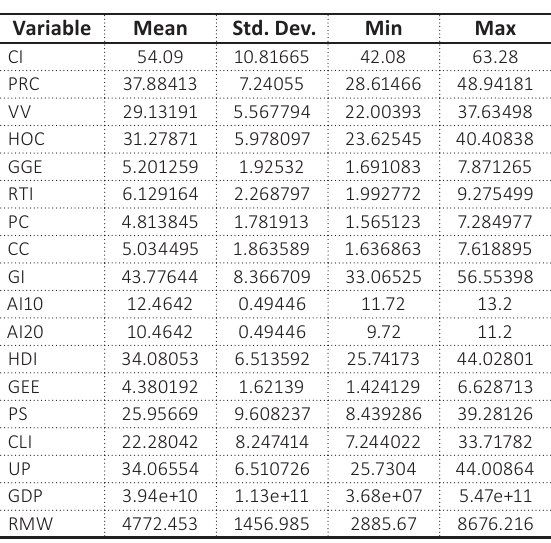
Table 5. Descriptive statistics for the first cluster